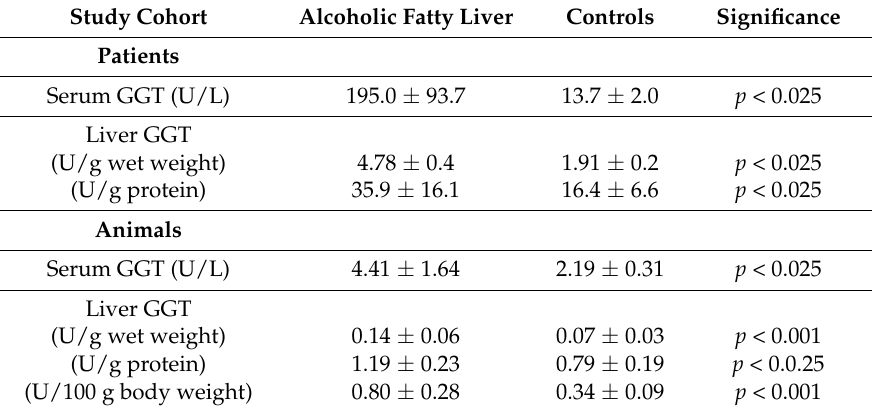
Table 6. GGT activities in AFL. Studied were 19 patients with AFL and nine patients without AFL. Animals: eight rats with AFL, fed chronically with an alcohol-containing diet were compared with eight controls that were fed control diets. Data are given as means ± SD, adapted from a previous report [295]. Abbreviations: AFL, Alcoholic fatty liver; GGT, gamma‐glutamyltransferase.